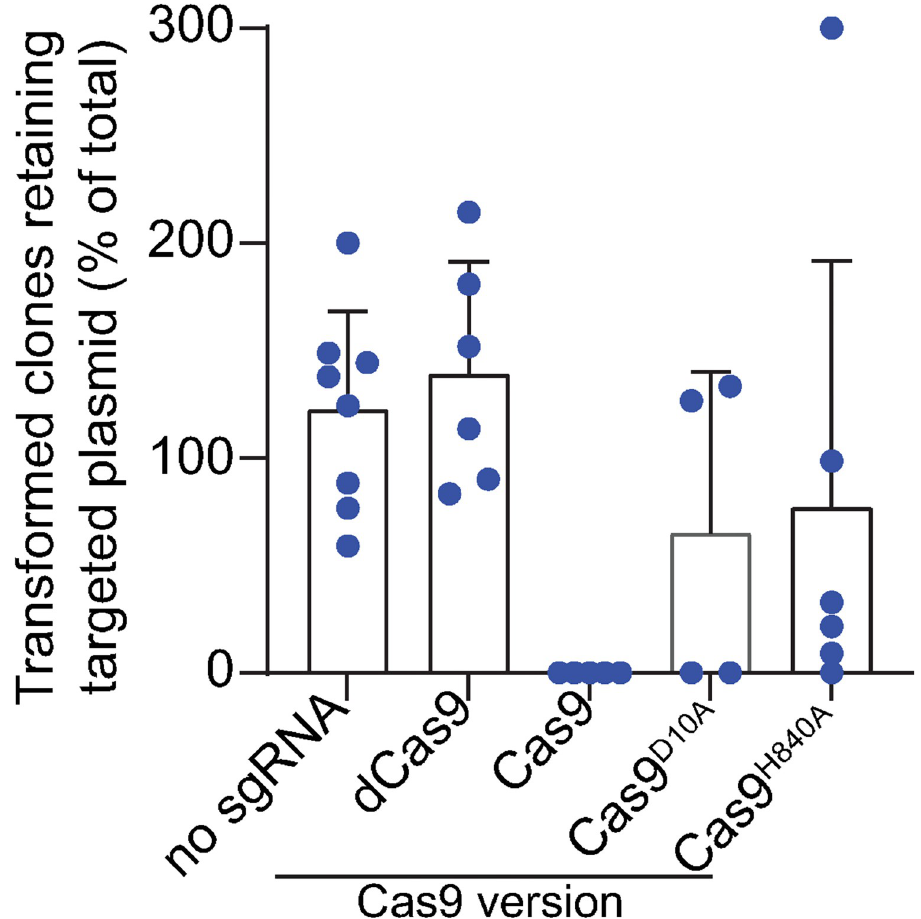
Fig 4. Summary of the B . burgdorferi transformation results. Graph compiling the plasmid retention values measured in experiment 3 described in Tables 5 and 6. Plasmid retention was calculated by dividing the concentration of cells that received the Cas9/sgRNA-expressing shuttle vector and retained the targeted plasmid by the concentration of cells that received the shuttle vector for any given electroporation. Experimental samples were grouped as follows. The “No sgRNA” group combines transformations of shuttle vectors encoding each of the four Cas9 versions (Cas9 WT , Cas9 D10A , Cas9 H840A , and dCas9) but no sgRNA. These transformations were plated under either kanamycin or gentamicin selection to assess retention of lp25 or lp28-1, respectively. All other transformations are grouped based on the version of Cas9 expressed from the shuttle vector and combine lp28-1 and lp25-targeting